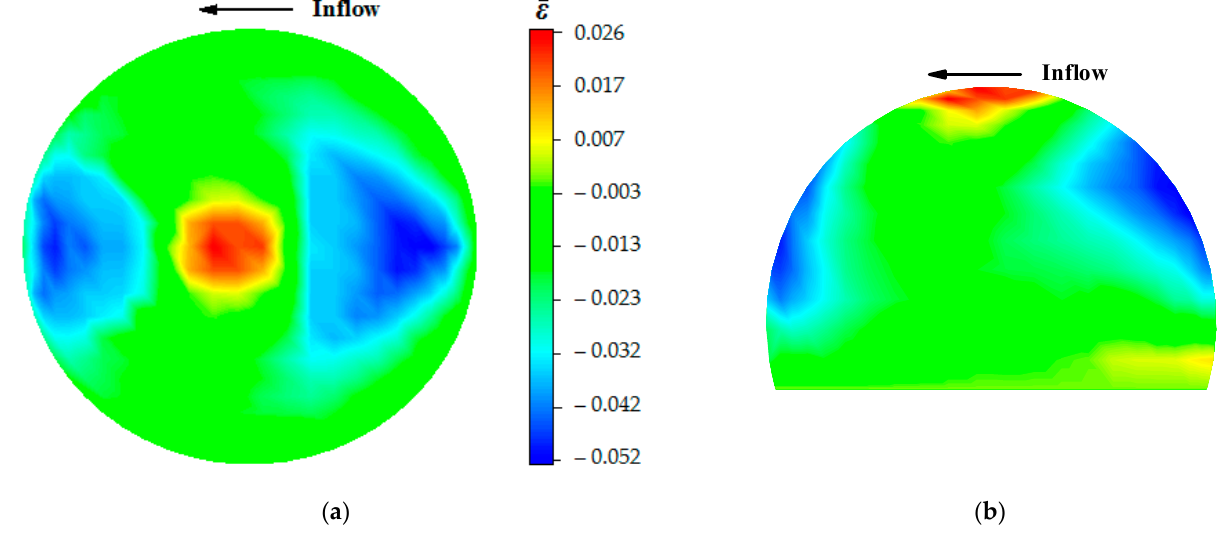
Figure 7. Contour of maximum principal strain: ( a ) top view and ( b ) side view.